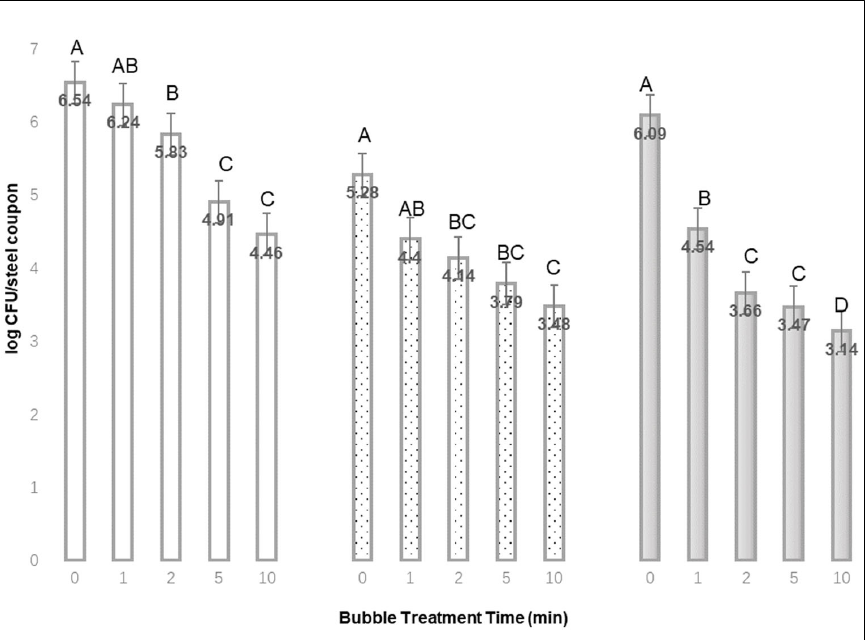
Figure 1. The mean log CFU Listeria monocytogenes recovered per stainless steel coupon after inocu ‐ lum drying times of 1 h , 24 h , or 48 h , and different bubble treatment times from 0 to 10 min (Mean of: 3 replications x 3 sam ‐ ples each). A,B,C,D Denote significant differences in recovery ( p < 0.01) between treatment times for each of the inoculum drying